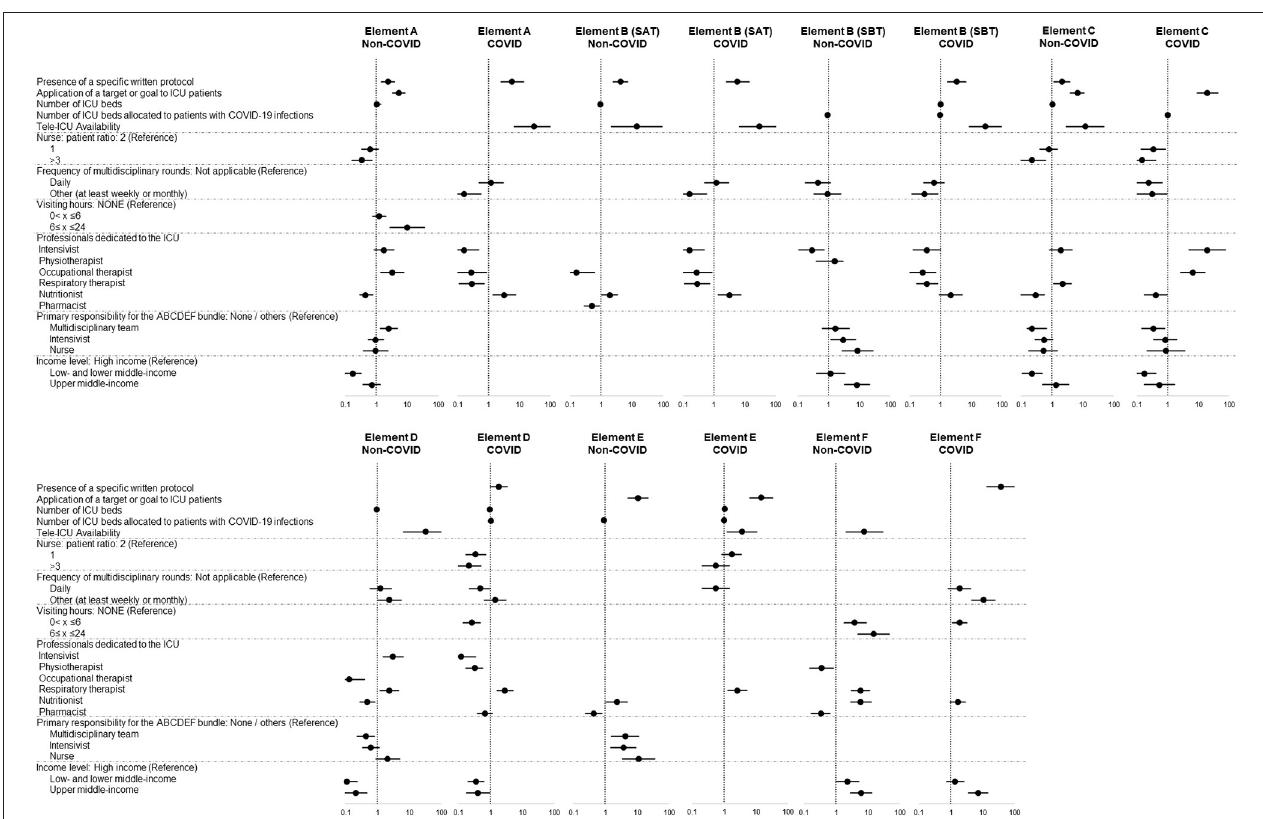
FIGURE 4 | Differences in associated independent factors in patients without and with COVID-19 infections. Data in figure are shown as adjusted odds ratio with 95% confidential interval. The blank lines in the figure are the variables which are excluded from the multivariable logistic regression analysis because the number of patients allocated to the category is too small ( ≤ 5 patients) to create the suitable model or the variables which are removed through the stepwise method with Akaike information